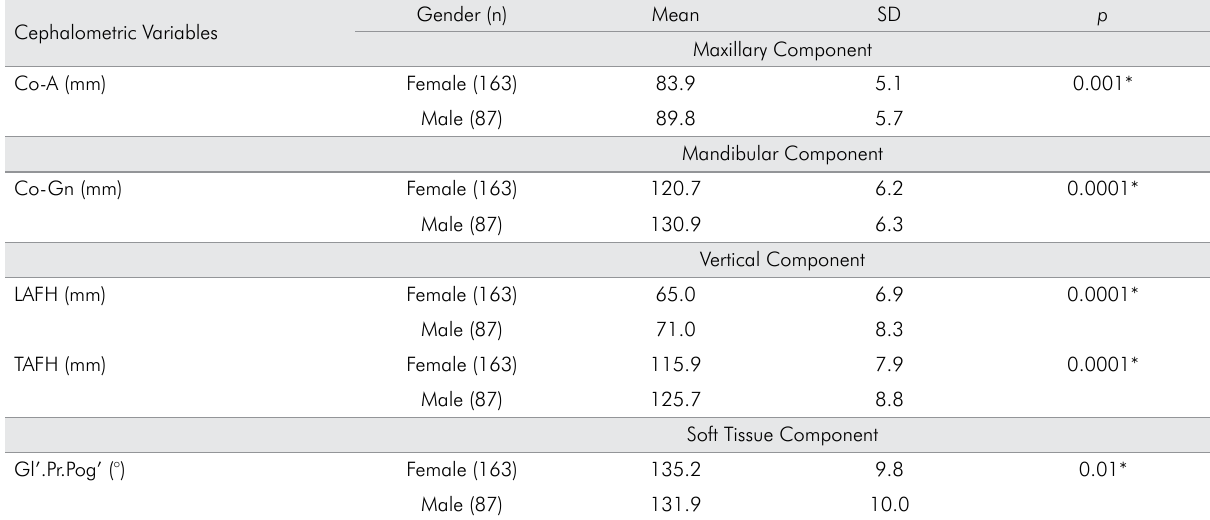
Table 3. Variables that showed significant differences in the comparison between different genders (female and male): Mean, Standard Deviation (SD), independent t test ( p ).